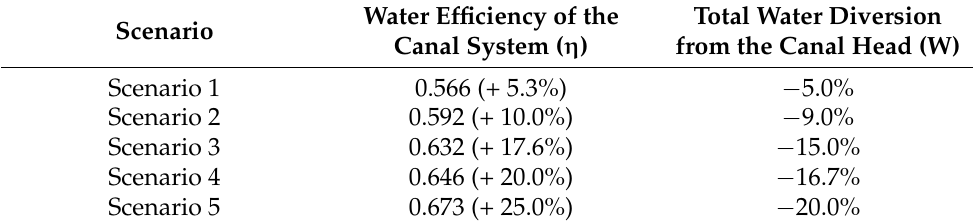
Table 6. Combination of different water-saving